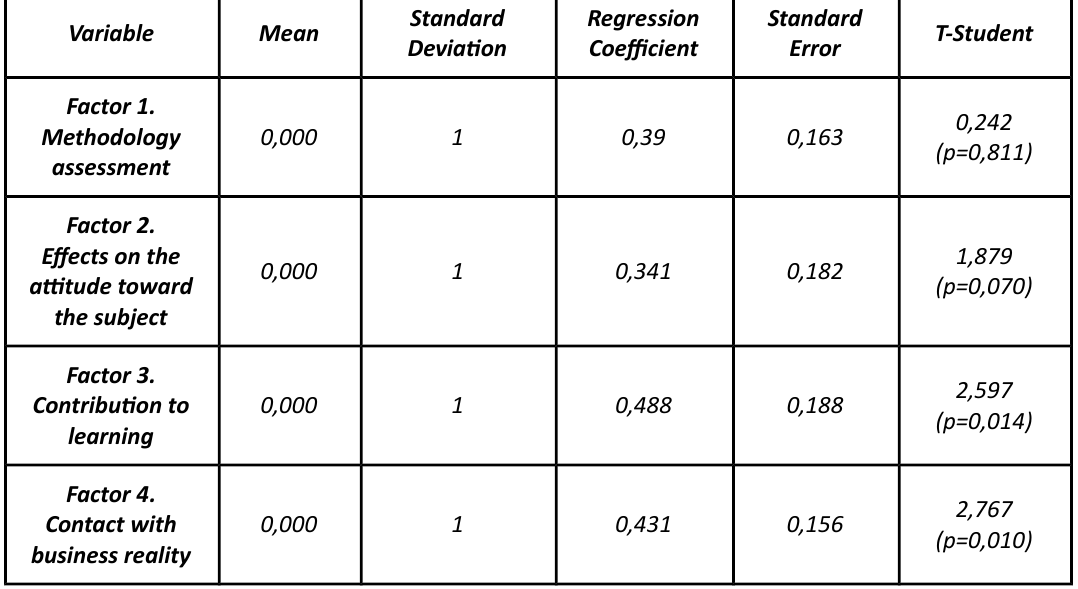
Table 6. Regression